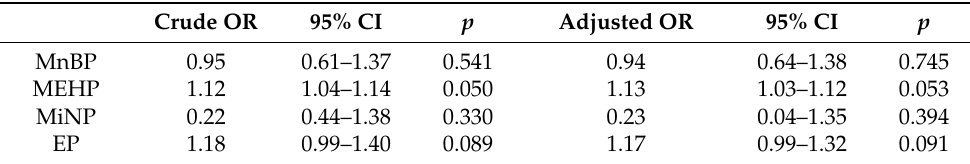
Table 4. Results of the logistic regression for the association between chemical concentrations and the EPDS.